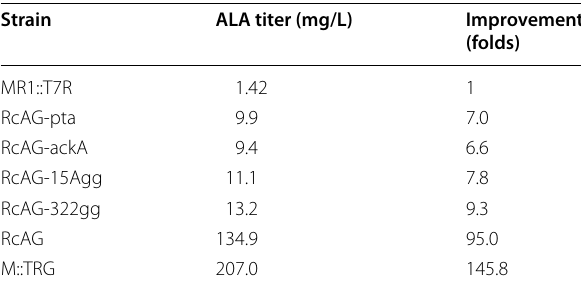
Table 3 Summary of ALA production in